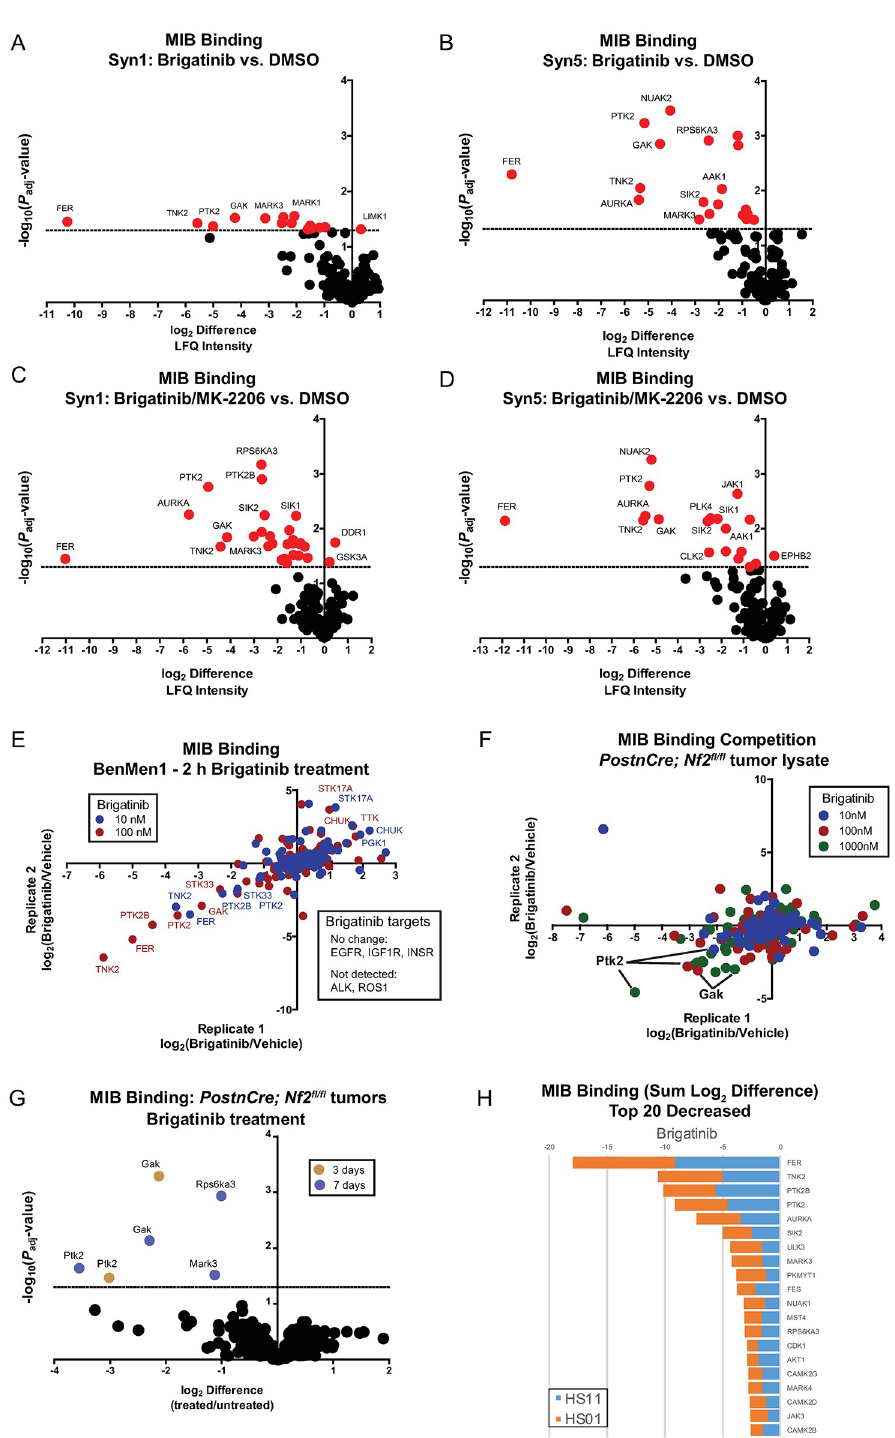
Fig 3. MIB/MS kinome profiling reveals brigatinib target specificity in multiple NF2 -deficient cell models. (A-D) MIB/MS kinome profiling was performed following treatment of Syn1 and Syn5 cells with vehicle (DMSO), brigatinib (1 μ M) or the combination of MK-2206 (0.5 μ M) and brigatinib (1 μ M) for 24h in biological triplicate. MIB binding (log2LFQ intensities) were used for comparisons and the volcano plots indicate log2 difference and significance (5% FDR, indicated by dashed line). (E) MIB/MS kinome profiling was performed following treatment of Ben-Men-1 cells with vehicle (DMSO) or brigatinib (10nM, blue or 100nM, red) for 2h in biological duplicate. The log2 difference in